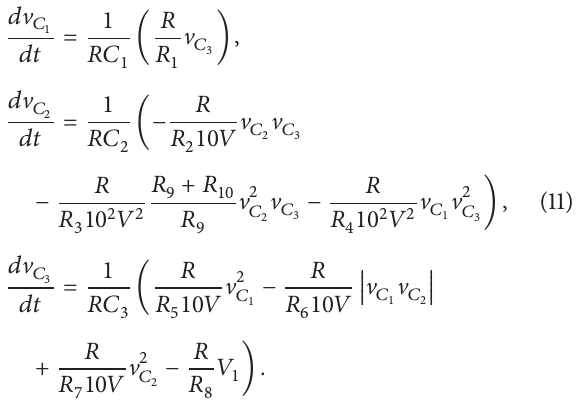
50]. Our designed circuit is shown in Figure 7, in which there are three integrators ( 𝑈 1 – 𝑈 3 ) with corresponding output – V 𝐶 ). The absolute nonlinearity is realized by the voltages ( V 𝐶 1 3 circuitry including two operational amplifiers ( 𝑈 4 , 𝑈 5 ) and two diodes ( 𝐷 1 , 𝐷 2